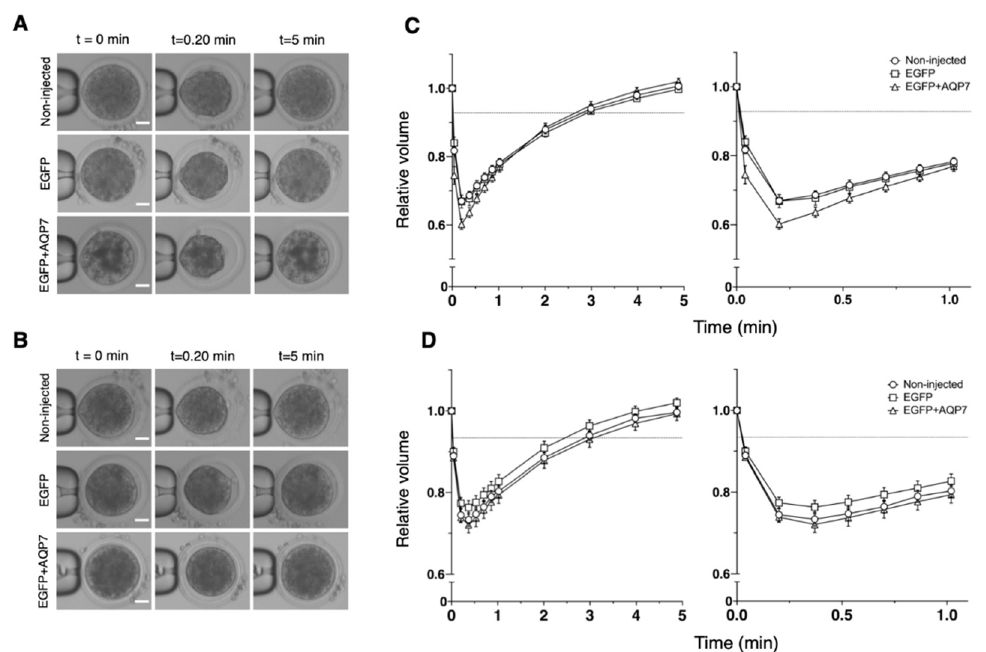
Figure 5. Osmotic behavior of non-injected MII bovine oocytes (circles), EGFP cRNA-injected (squares), or EGFP+AQP7 cRNA-injected-oocytes (triangles) exposed to 9.5% Me 2 SO or 8% EG for 5 min at 25 °C (( A ) and ( B ), respectively). ( A , B ) Representative phase-contrast microscopy images of oocytes measured in C and D are shown. Scale bar = 30 µm. ( C , D ) Summary data represented as the relative mean volume ± SEM. Non-injected oocytes: Me 2 SO n = 13; EG n = 14; EGFP cRNA-injected oocytes: Me 2 SO n = 10; EG n = 11; and EGFP+AQP7 cRNA-injected oocytes: Me 2 SO n = 11; EG n = 13.